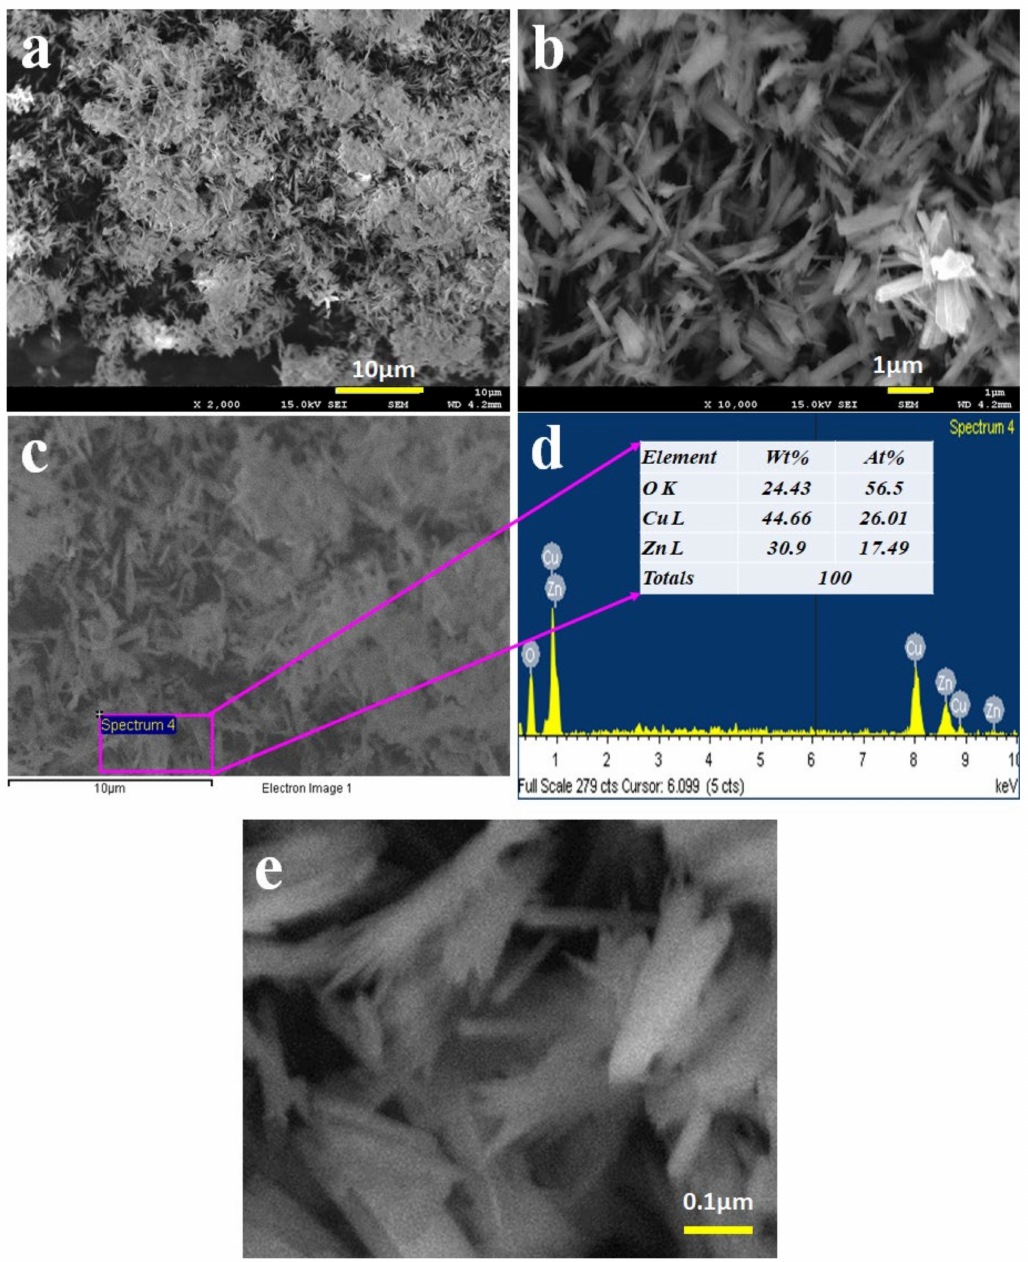
Figure 1. Structural and compositional analyses of CuO/ZnO nanomaterials. ( a , b ) Exploration of the low and high magnified images of the prepared nanomaterials captured by FESEM. ( c ) EDS-captured image of CuO/ZnO NSs. ( d ) Compositional analysis of CuO/ZnO NSs in a selected area was performed by EDS investigation. ( e ) Magnified image of CuO/ZnO